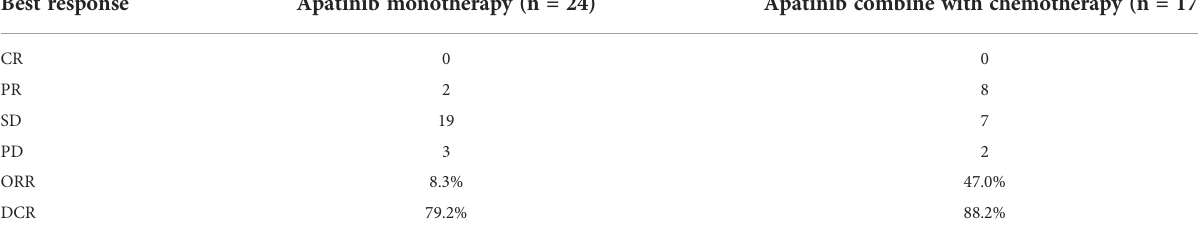
TABLE 2 Best response of patients during apatinib treatment according to different